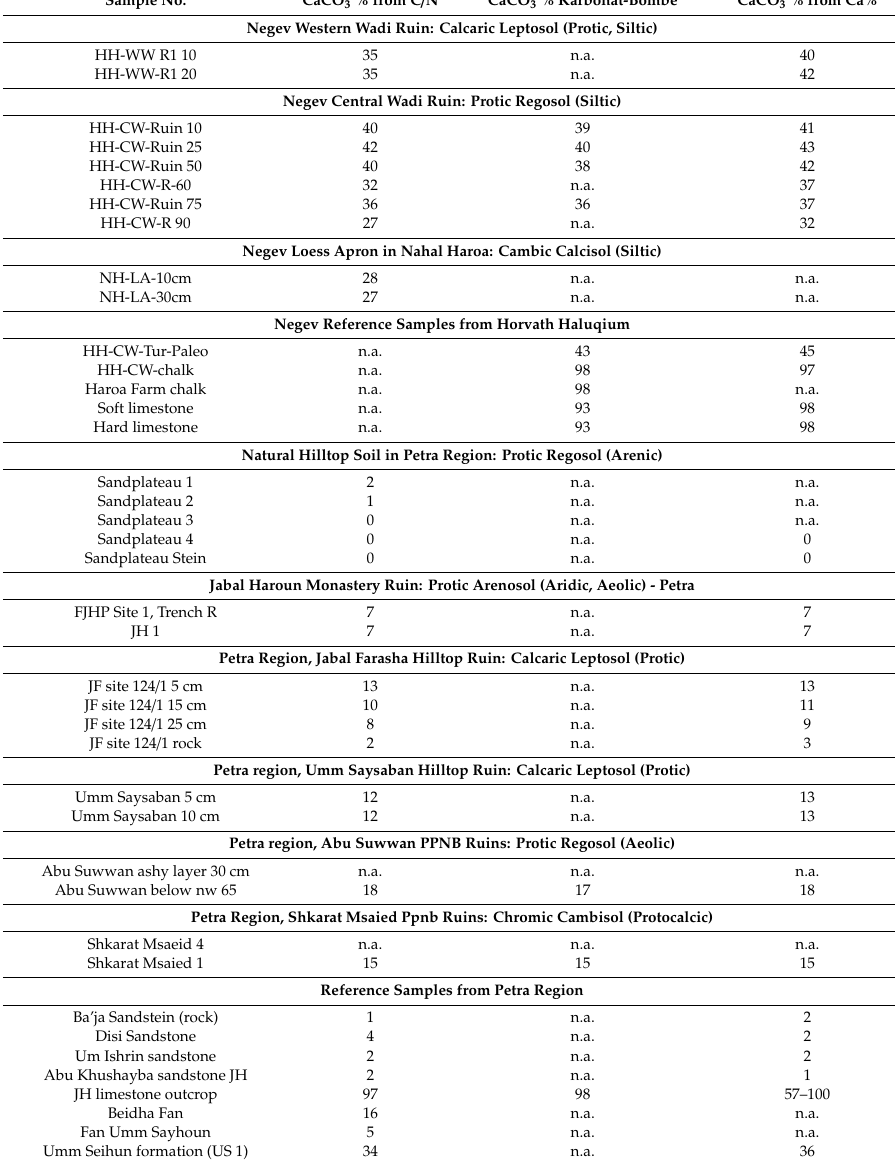
Table A1. Detailed results of CaCO 3 -analyses from measuring samples before and after ignition at 500 ◦ C in the C / N-analyzer, from gas pressure measured by the Karbonat-Bombe and calculated from Ca-contents that were determined by